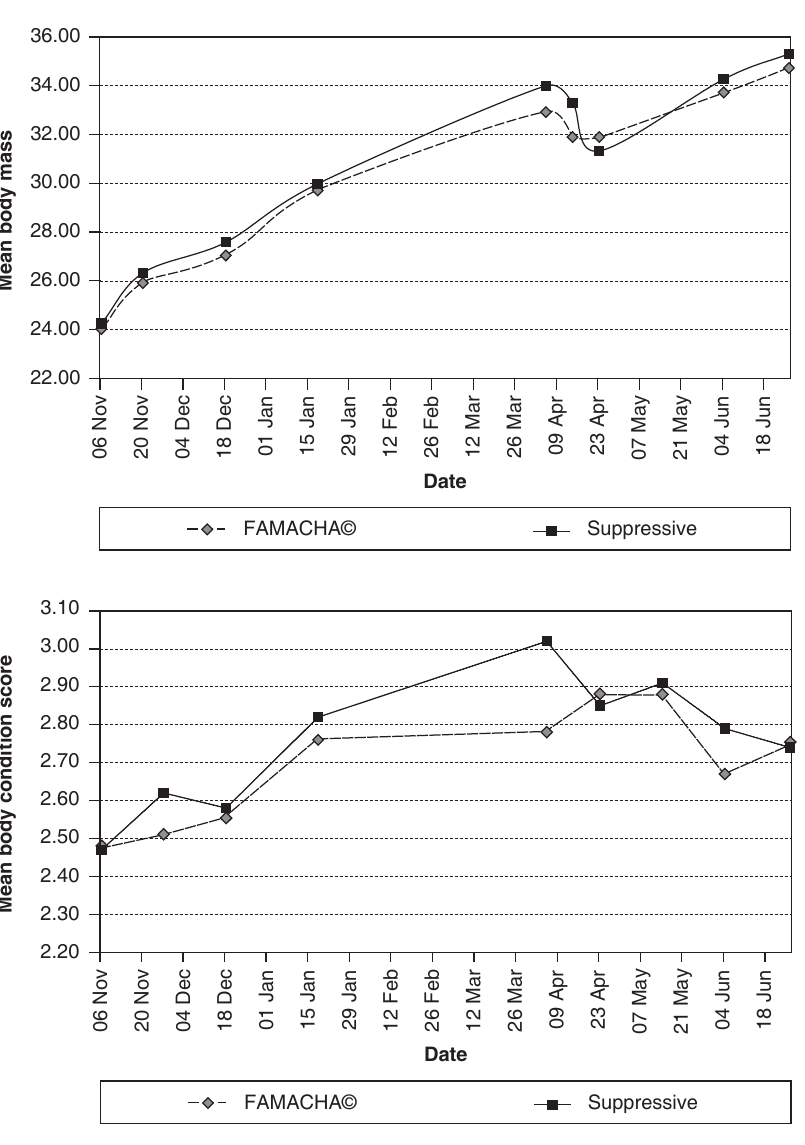
FIG. 2 Experiment 1 (Farm 1, wethers in replacement ram flock): Mean body condition